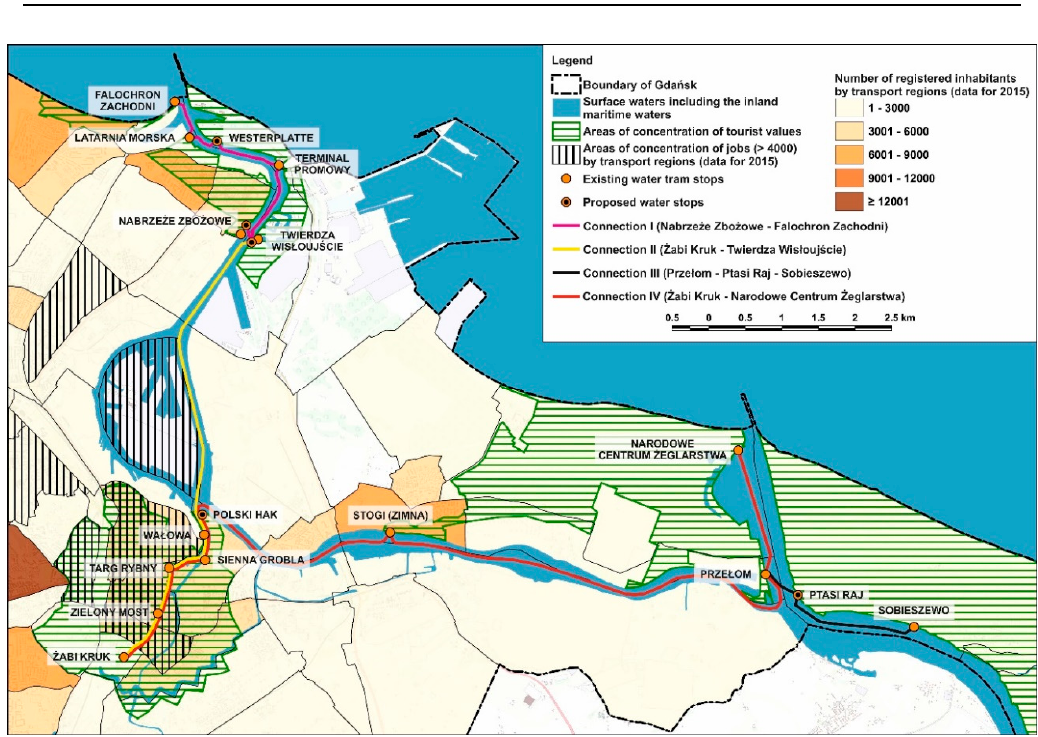
Figure 2. The proposed development directions of the inner-city water tram lines.